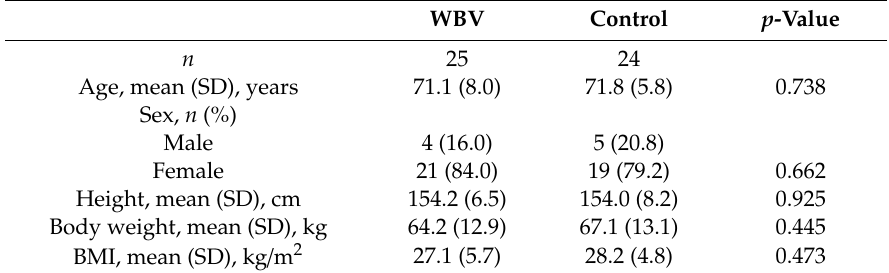
Table 1. Baseline characteristics of the participants in two